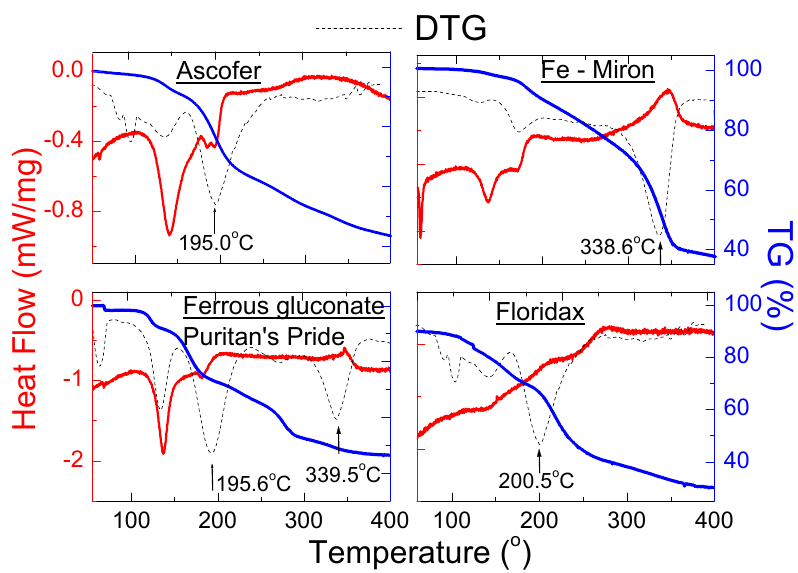
Figure 8. DSC and TG/DTG curves of dietary supplements containing iron (II) gluconate: Ascofer , Fe-Miron , Iron gluconate Puritan’s Pride and Floridax . Table 6. Parameters determined from TG and DSC analysis for drugs containing. iron (II) gluconate.